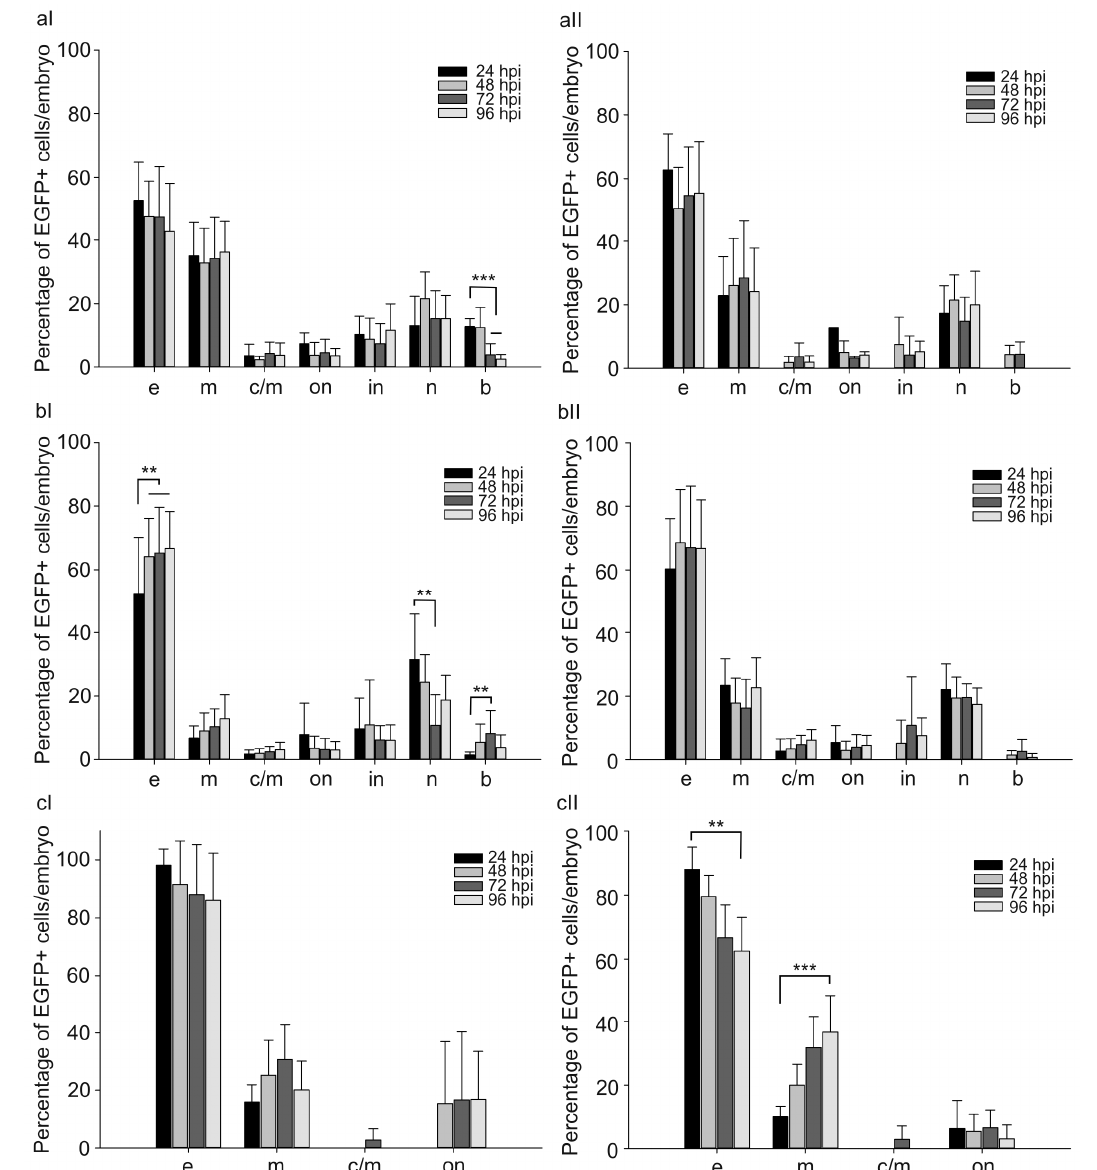
Figure 4. Proportion of EGFP-positive cells of di ff erent morphology in normal ( I ) and abnormal ( II ) zebrafish injected with 30 attomoles of ( a ) pGL3(CMV-EGFP), ( b ) pGL3(CTGF-EGFP), and ( c ) pGL3(FAP-EGFP) from 24 to 96 h after injection (hpi). Abscissa, types of EGFP+ cells in injected embryos: e—surface epithelial cells, m—myocytes, c/m—cardiomyocytes, on—outer notochord sheath cells, in—inner notochord sheath cells, n—neural cells, b—blood cells. The values were averaged for three independent experiments ( n = 62 normal and 10 abnormal animals for pGL3(CMV- EGFP), n = 53 normal and 15 abnormal animals for pGL3(CTGF-EGFP), n = 85 normal and 28 abnormal animals for pGL3(FAP-EGFP)). Error bars indicate standard deviation (SD), ** p < 0.01, *** p < 0.001.